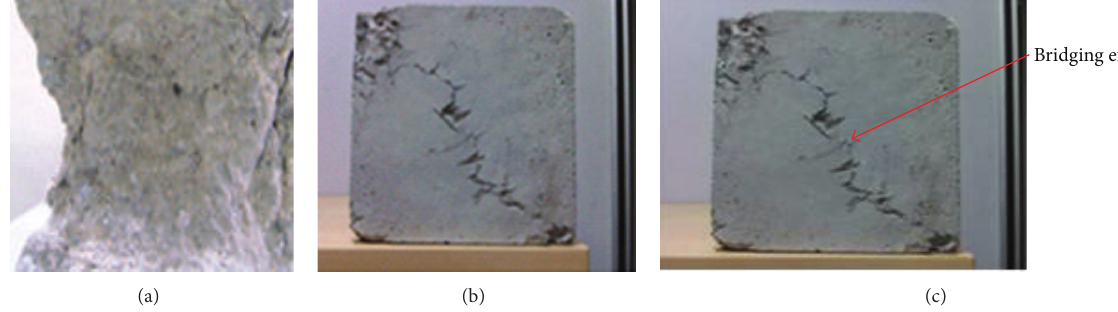
Figure 4: (a) Failure mode of NRC. (b) Failure mode of HSFRC. (c) Bridging effect of steel fibers in HSFRC cube.